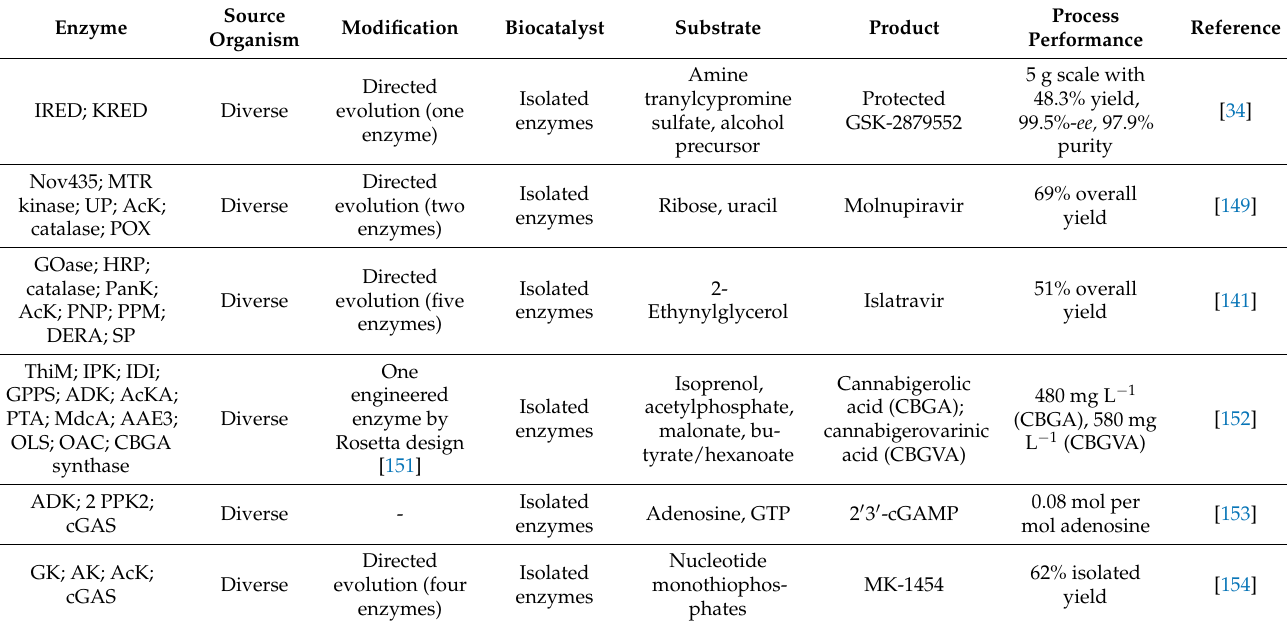
Table 4. Overview of mentioned enzyme